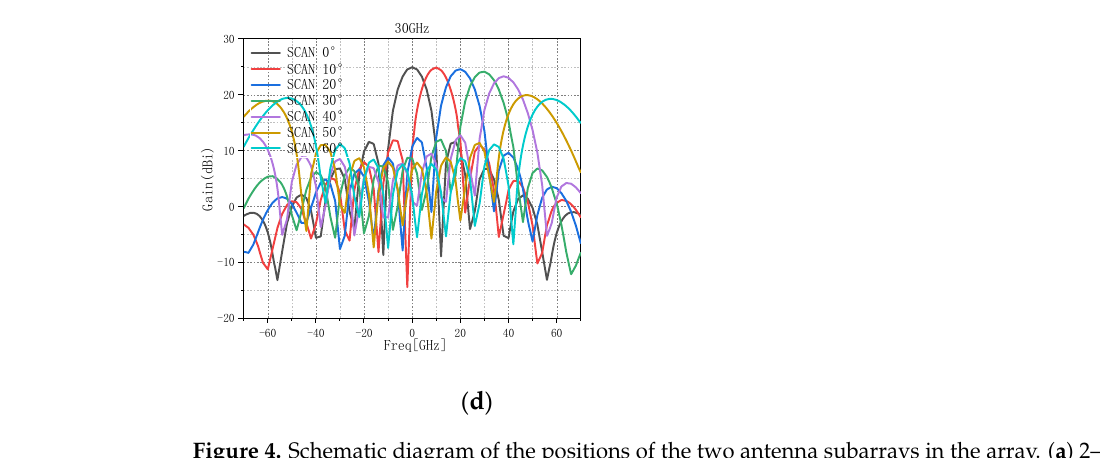
Figure 4. Schematic diagram of the positions of the two antenna subarrays in the array. ( a ) 2–18 GHz of a subarray in the array. ( b ) Test environment and partial results of 2–18 GHz array. ( c ) Position of a subarray at 26–40 GHz in the array. ( d ) Test environment and partial results of 26–40 GHz array.